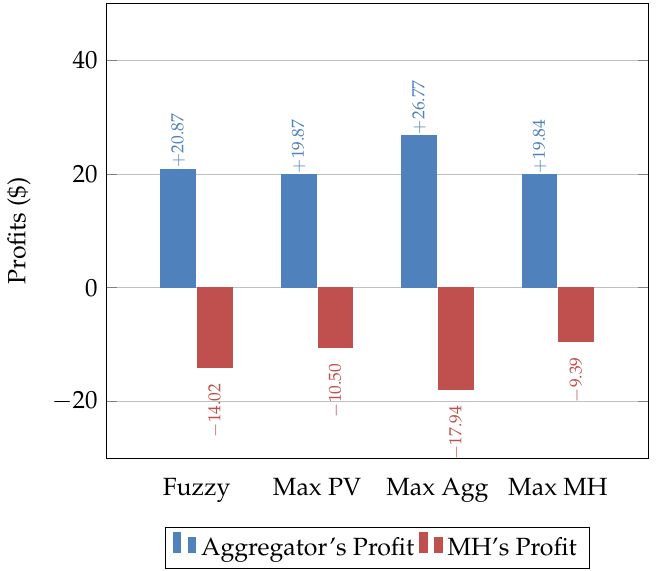
Figure 12. Aggregator’s and households’ profits for the different decision maker